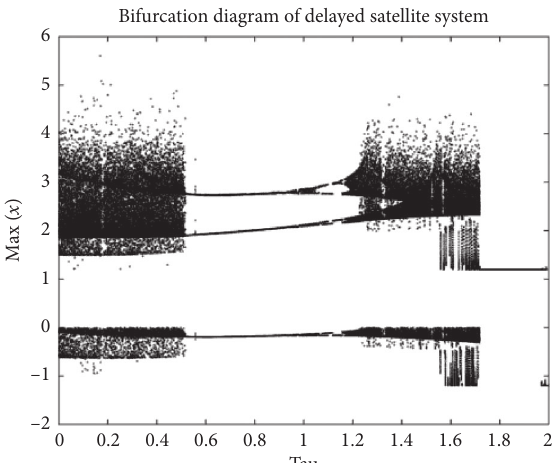
Figure 6: Chaotic solution of FOS delay model (37) in x ( t ) x ( t − τ ) plane with a � 0 . 4 , b � 0 . 175 , c � 0 . 4 , α � 0 . 995, and τ � 0 . 2.